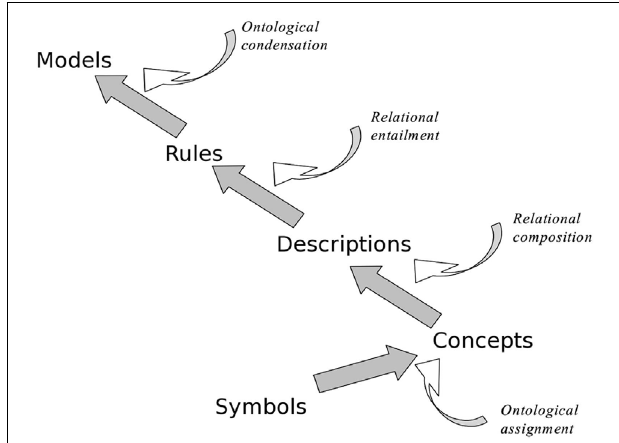
FIGURE 4 |The “ontological ladder,” which formalizes knowledge as a hierarchy of increasingly complex and semantically rich conceptual